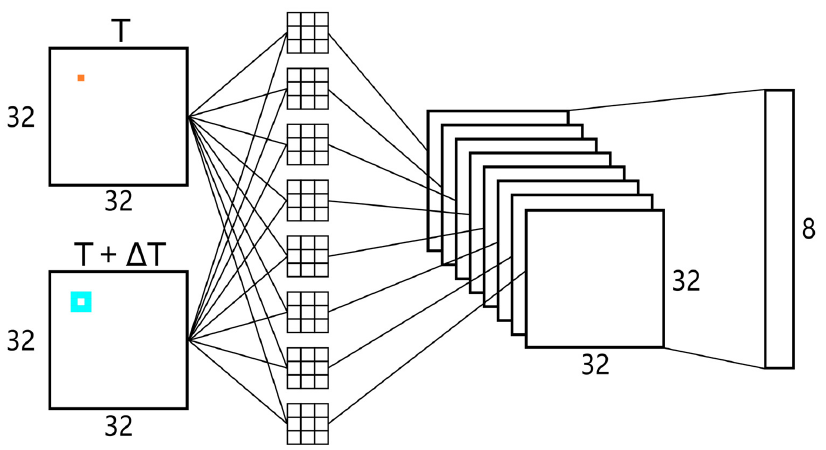
Figure 8. Schematic of the time-considered CNN. Table 4. Detection results of the time-considered CNN within the background with separated noises.